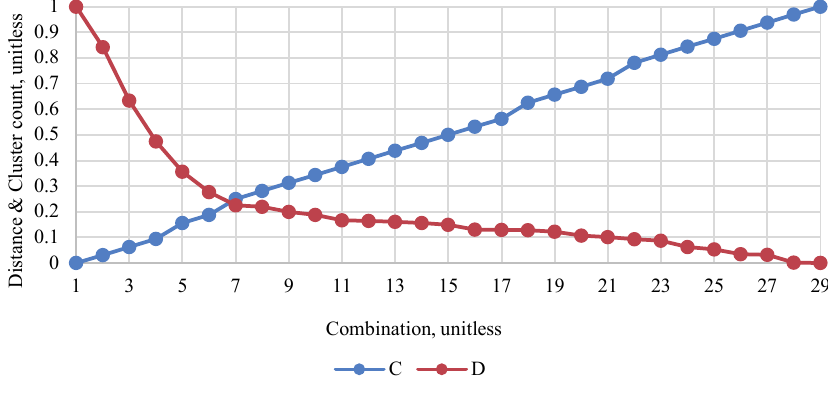
Fig. 4. Finding the optimal cluster count (C–Cluster; D–Distance).